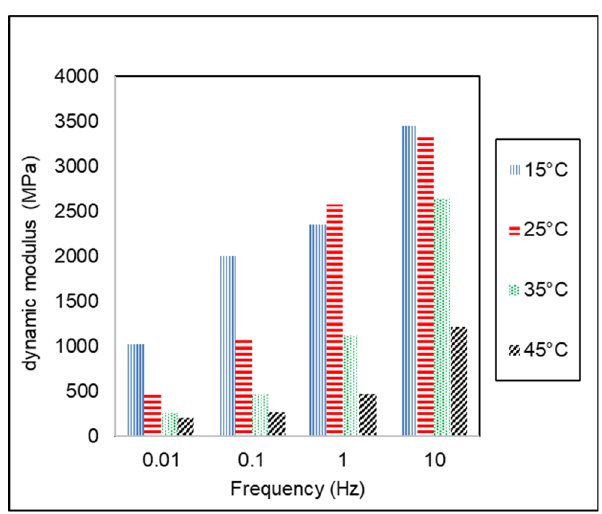
Figure 6. Variation of Dynamic Modulus of AC-WC mixture with temperature and frequency.